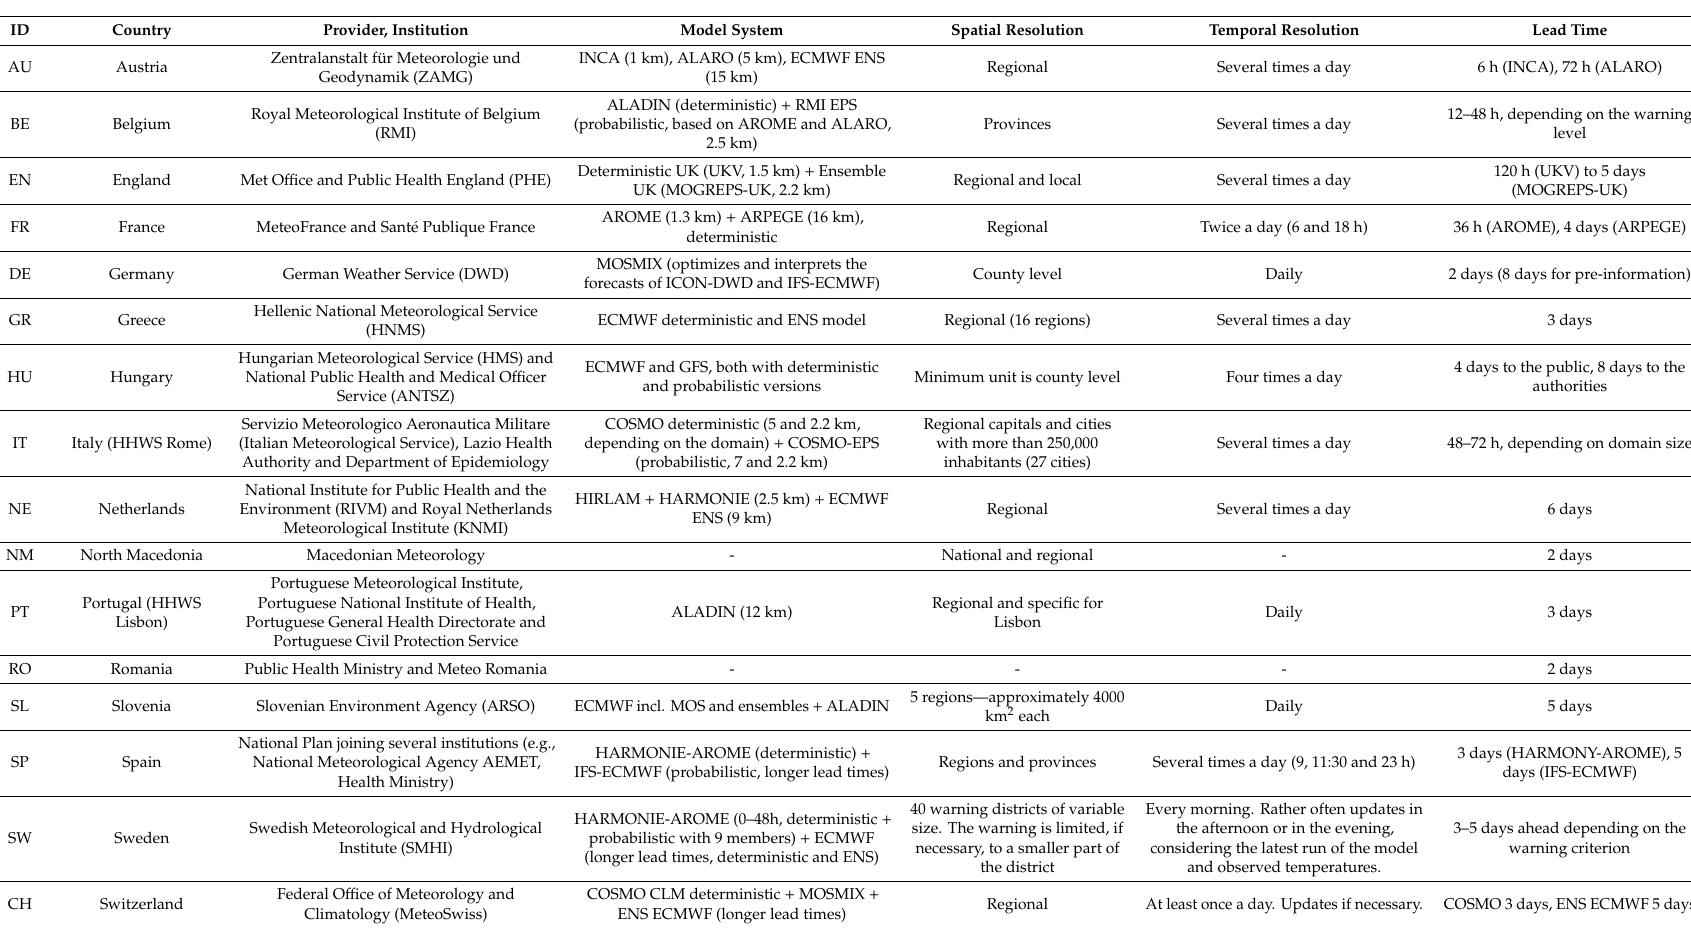
Table 1. Characteristics of the weather forecast system in European countries. The identifier (ID) for each country is used as reference also in Tables 2–4.